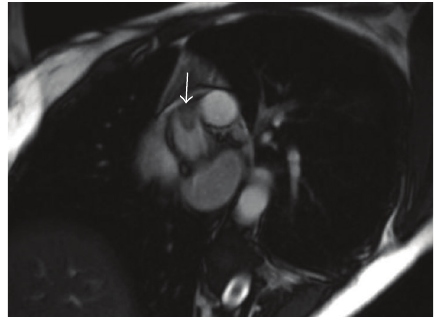
Figure 2: MRI image showing that there is a 1.3cm pedunculated mass that arises from theright coronary cusp of theaortic valve. This mass also demonstrates enhancement on late gadolinium-enhanced images and is hyperintense on fat sequences consistent with papil- lary